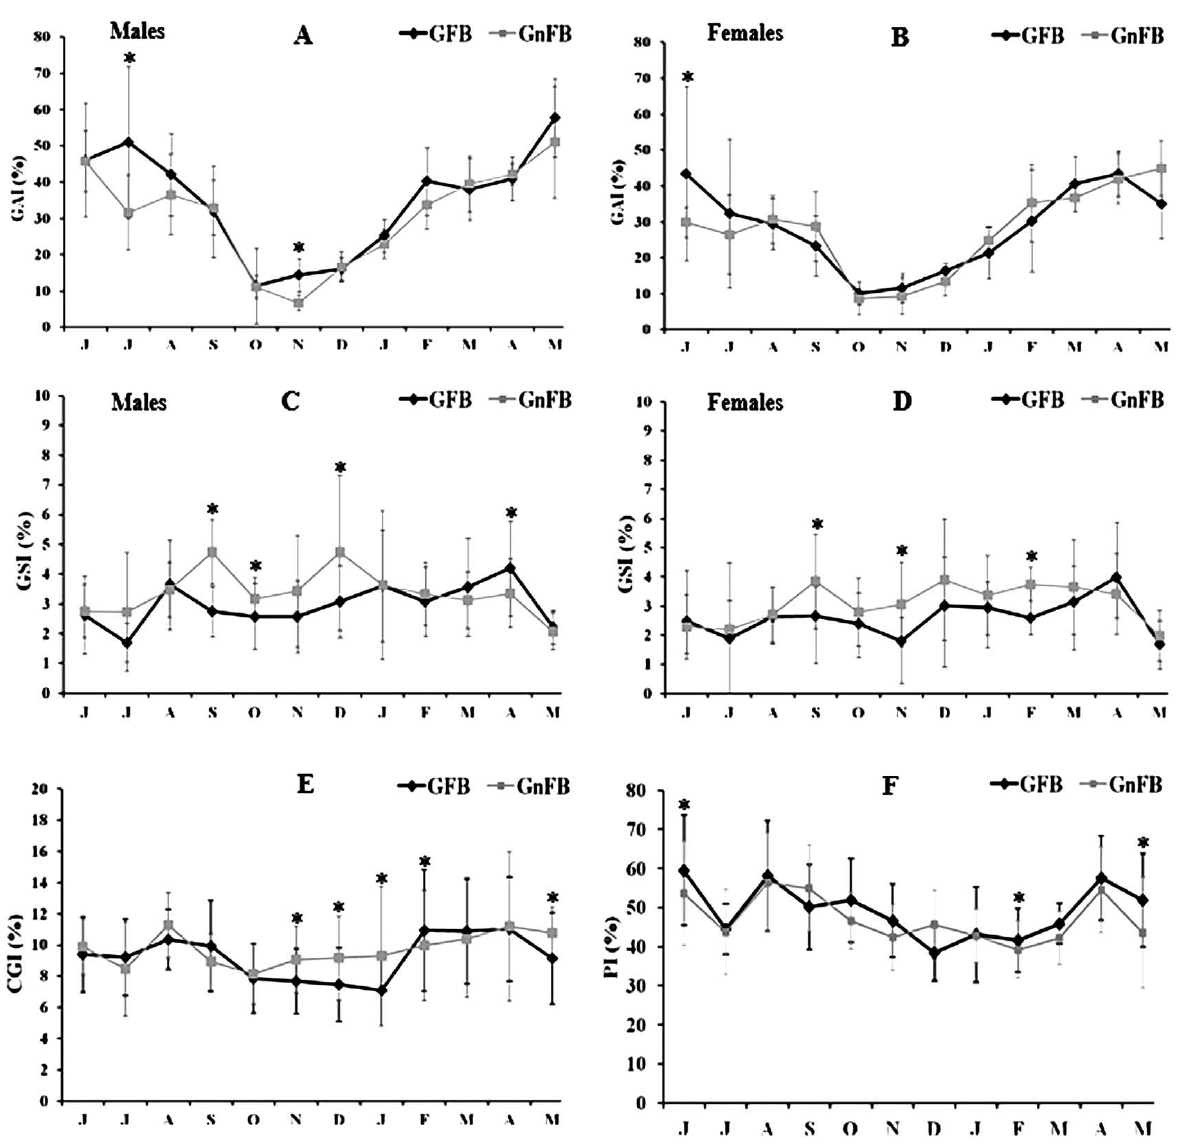
Fig. 5. – Comparison of the monthly variation of the gonad area index (GAI) in males (A) and females (B); gonadosomatic index (GSI) in males (C) and females (D); capsule gland index (CGI) (E) and penial index (PI) (F) in S. haemastoma non-fouled (GnFB) and fouled (GFB) by epibiotic barnacles (June 2009 - May 2010). (*) Statistically significant differences GnFB and GFB in each